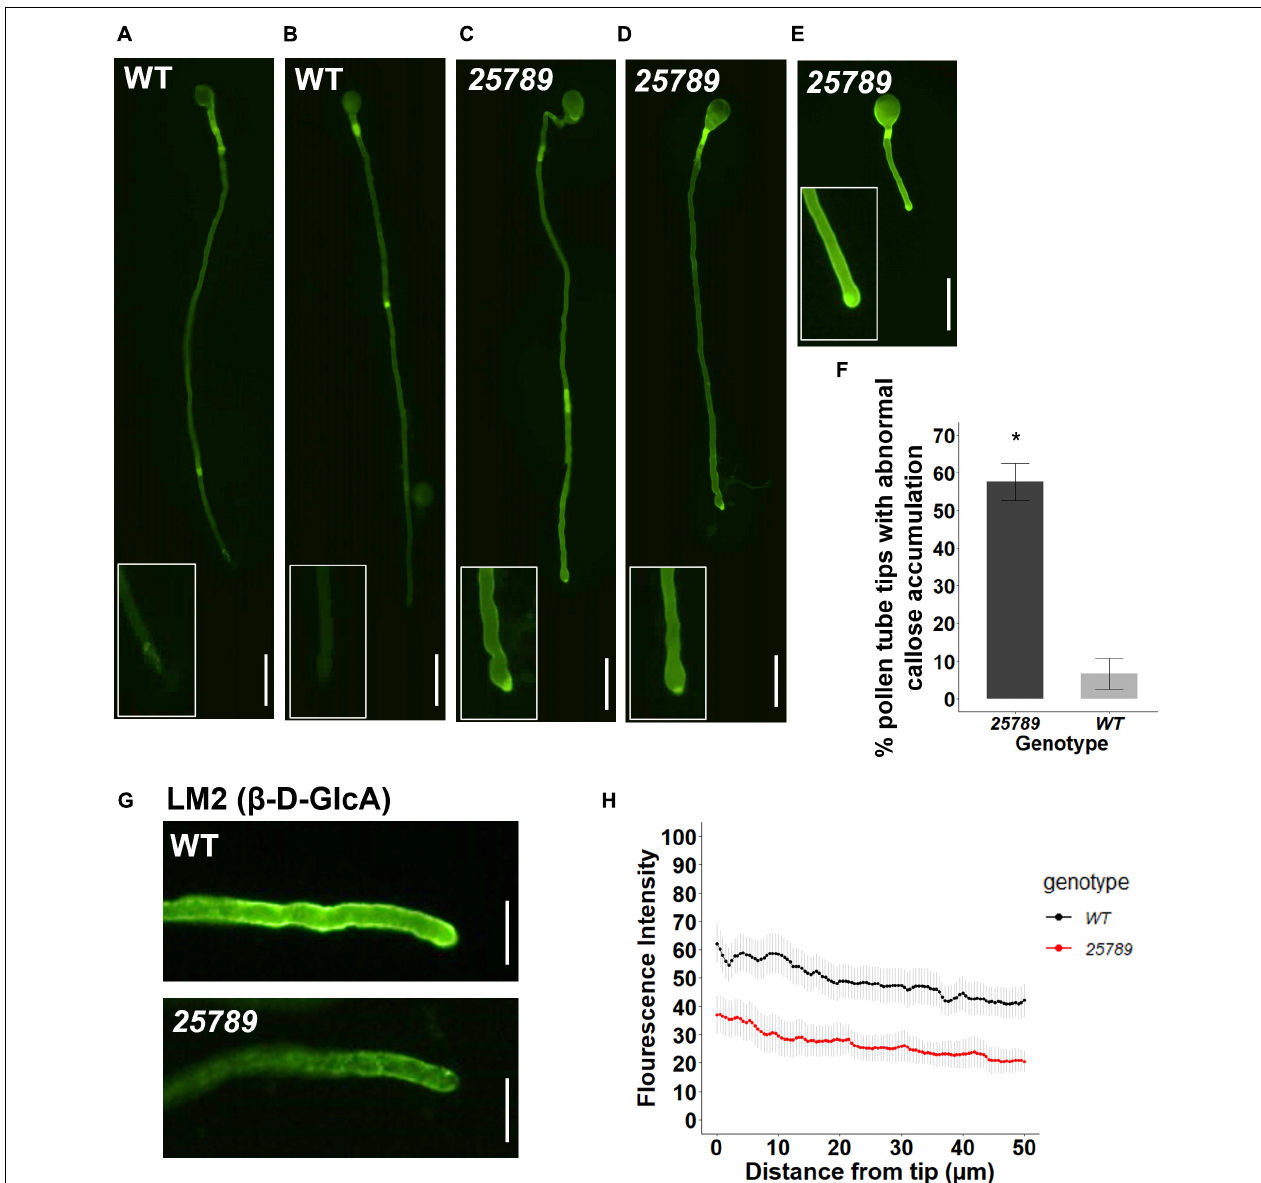
FIGURE 8 | galt25789 mutant pollen tubes displayed high levels of callose distribution signal at the mutant pollen tube tip and low intensity of LM2 antibody signal during in vitro pollen tube growth. (A,B) Cytochemical staining of β -glucan (callose) with aniline blue shows WT pollen tube with callose signal in the shaft but lacks staining in the pollen tube tip (enlarged in inset). (C–E) displays representative images of abnormal galt25789 mutant pollen tubes with a higher callose signal at the pollen tube tip than the shaft (enlarged in inset). Quantification of abnormal callose deposition of pollen tube tips is shown in (F) . Values are expressed as percentage. Error bars denote mean ± SE, asterisks indicate statistically significant, p < 0.005 ( n ≥ 45 pollen tubes for each genotype). (G) Immunofluorescence labeling of cell wall epitopes probed with anti-AGP ( β -D-GlcA) MAbs LM2, displays strong staining of pollen tube tip and the surface of pollen tubes in WT. LM2 epitope signal is weaker in galt25789 mutant pollen tube tip and shaft. (H) Quantification of signal intensity from the pollen tube tip to 50 µ m down the shaft. Graph represents the mean ± SE of the fluorescent intensities for each genotype ( n ≥ 25 for each genotype). Scale bars = 50 µ m in (A–E) , 20 µ m in panel (G)